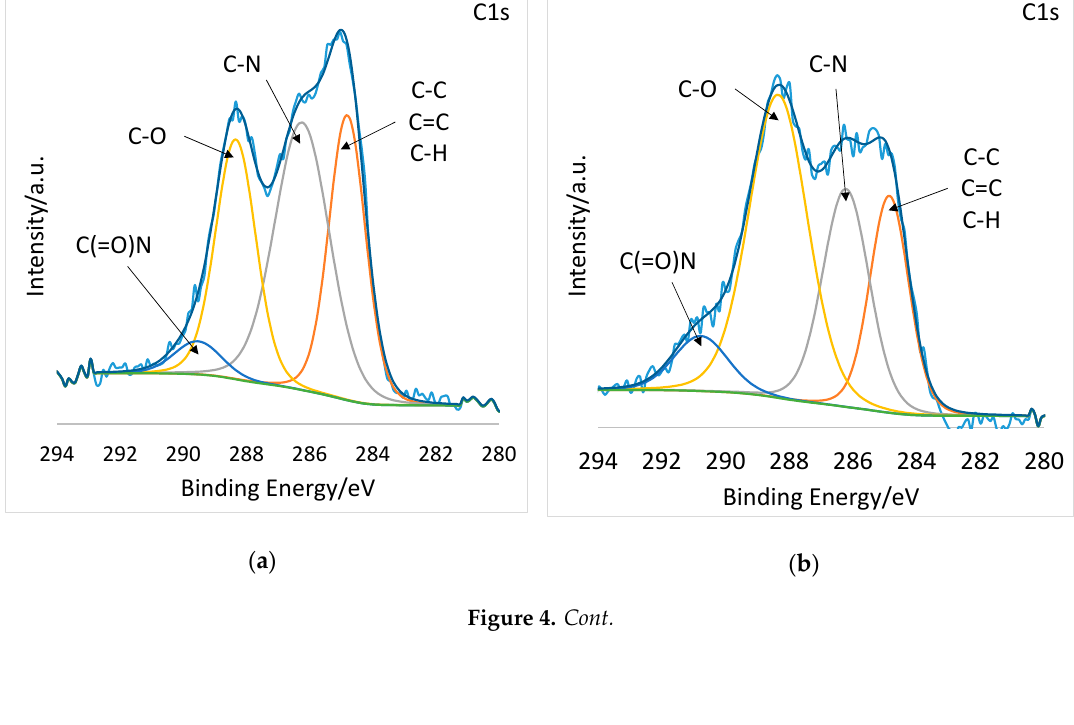
Figure 3. FTIR spectra of PSI, PSI-AAm and PSI-AAmp, where arrows from left to right indicate 1709, 1662, 1530 cm − 1 .